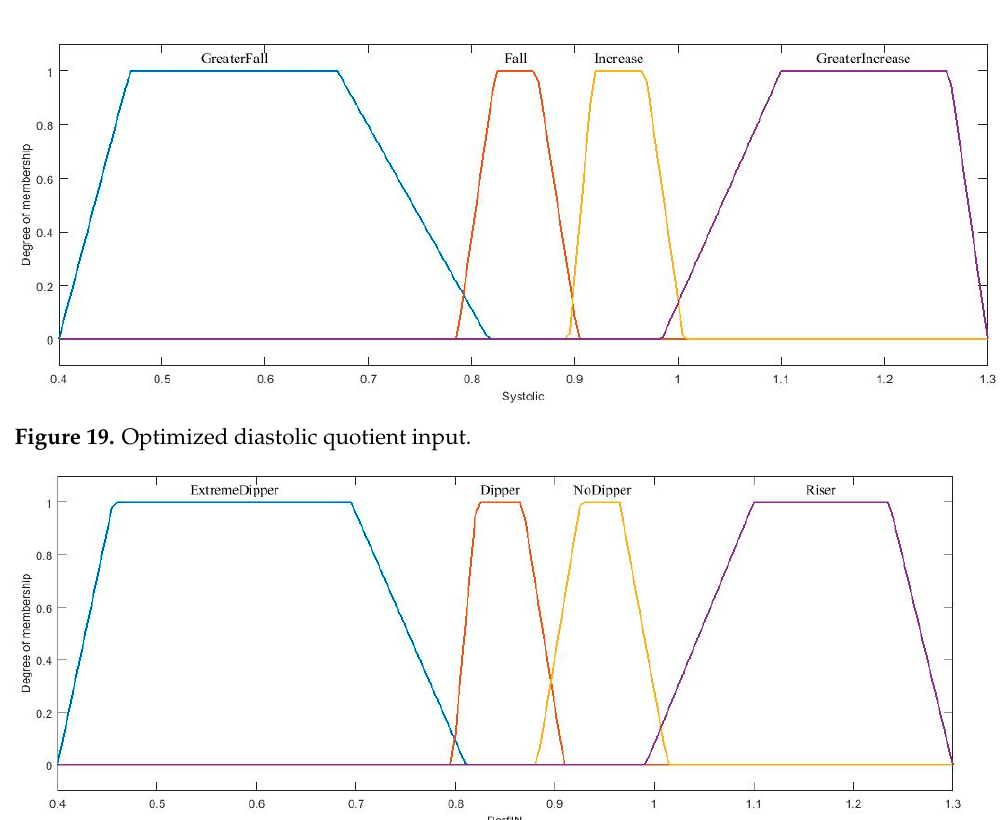
Figure 18. Optimized systolic quotient input.